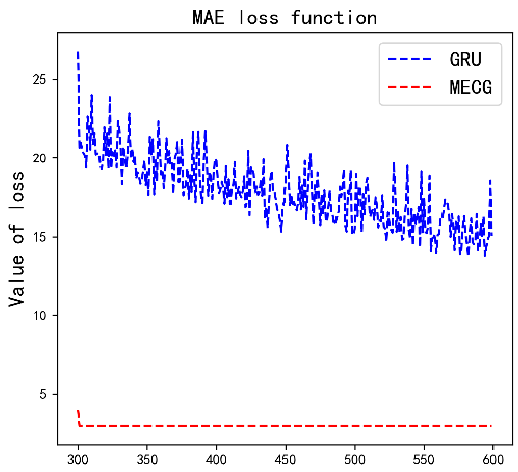
Figure 15. The convergence rate of GUR and MECG models after 300 iterations.